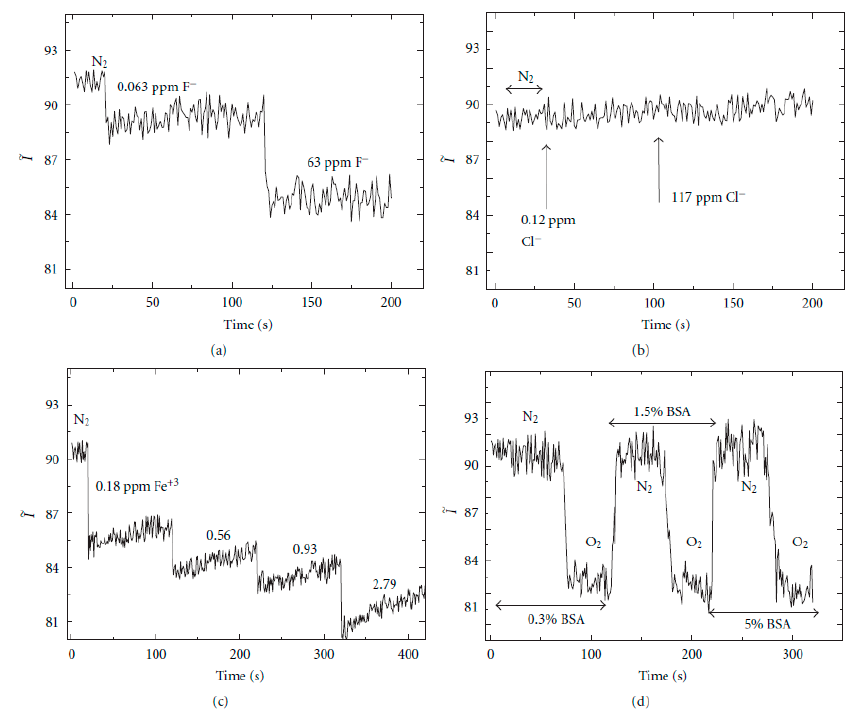
Figure 7. Potential interference of the DO measurement: sensor response to the presence of different species such as F − ( a ), Cl − ( b ), Fe 3+ ( c ) and bovine serum albumin (BSA) ( d ). Reprinted with permission from Ref. [44].